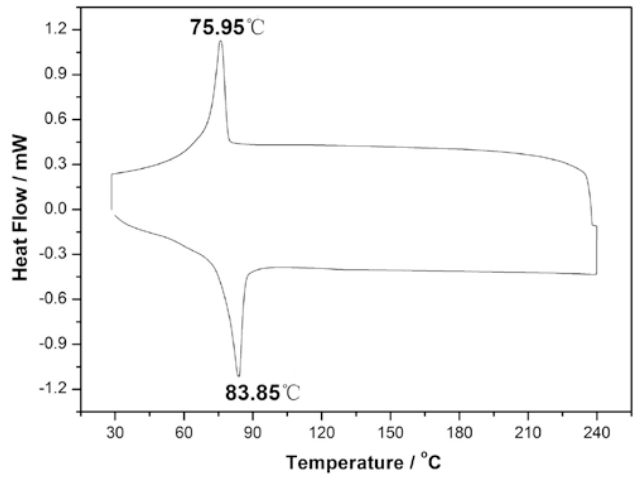
Figure 3. DSC curves of PFMA nanoparticles.